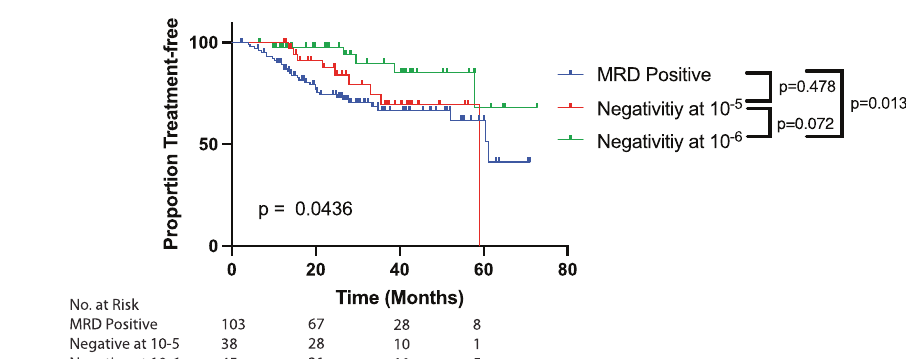
Fig. 1 Kaplan Meier curves for time to next treatment (TTNT) based on MRD status. Based on MRD status at Day 100 Post-ASCT evaluation. A The median TTNT was not reached for those patients who achieved negativity at 10 − 6 ; and was 60.5 months for patients who remained positive. B The median TTNT was not reached for reached for patients who achieved MRD negativity at 10-6, 59.1 months in those who achieved negativity at 10 − 5 , and 61 months who remained MRD positive. progression free and have sequential negative MRD measure- ments, but did not meet criteria for sustained MRD negativity due